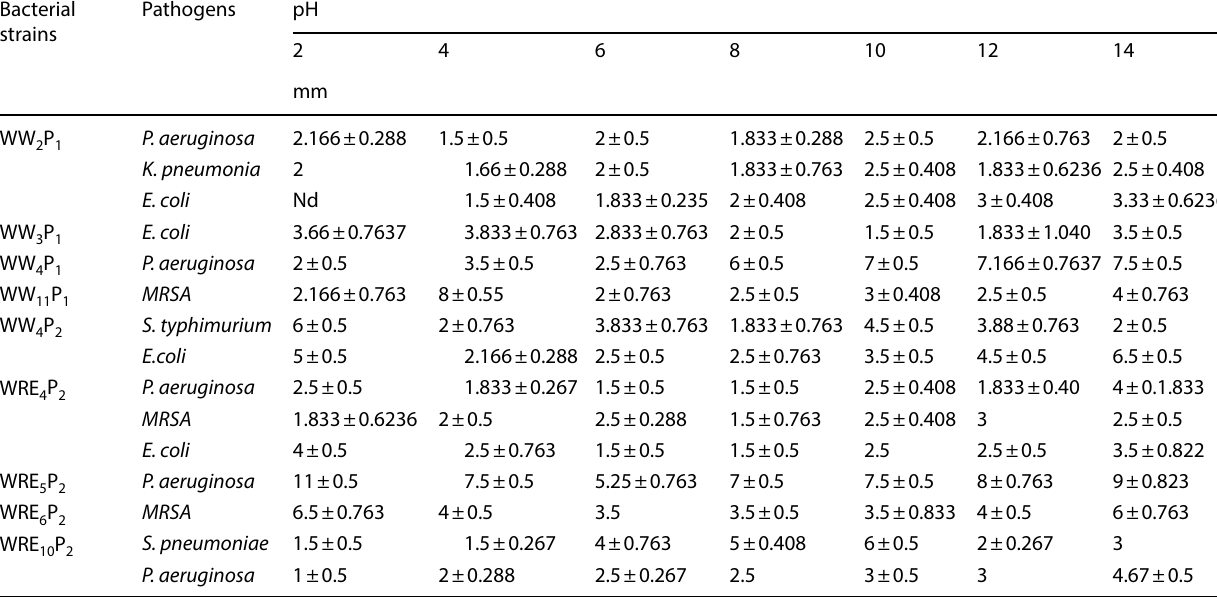
Table 6 Effect of pH on bacteriocins activity